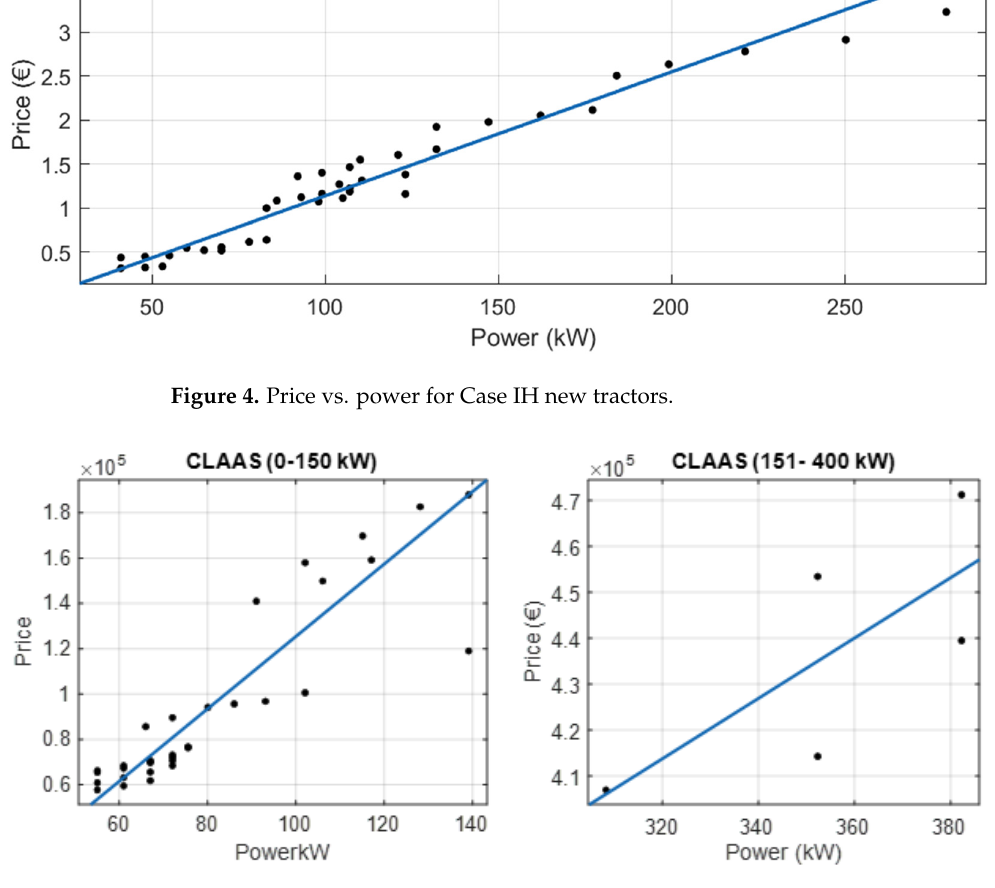
Figure 5. Price vs. power for Claas new tractors.